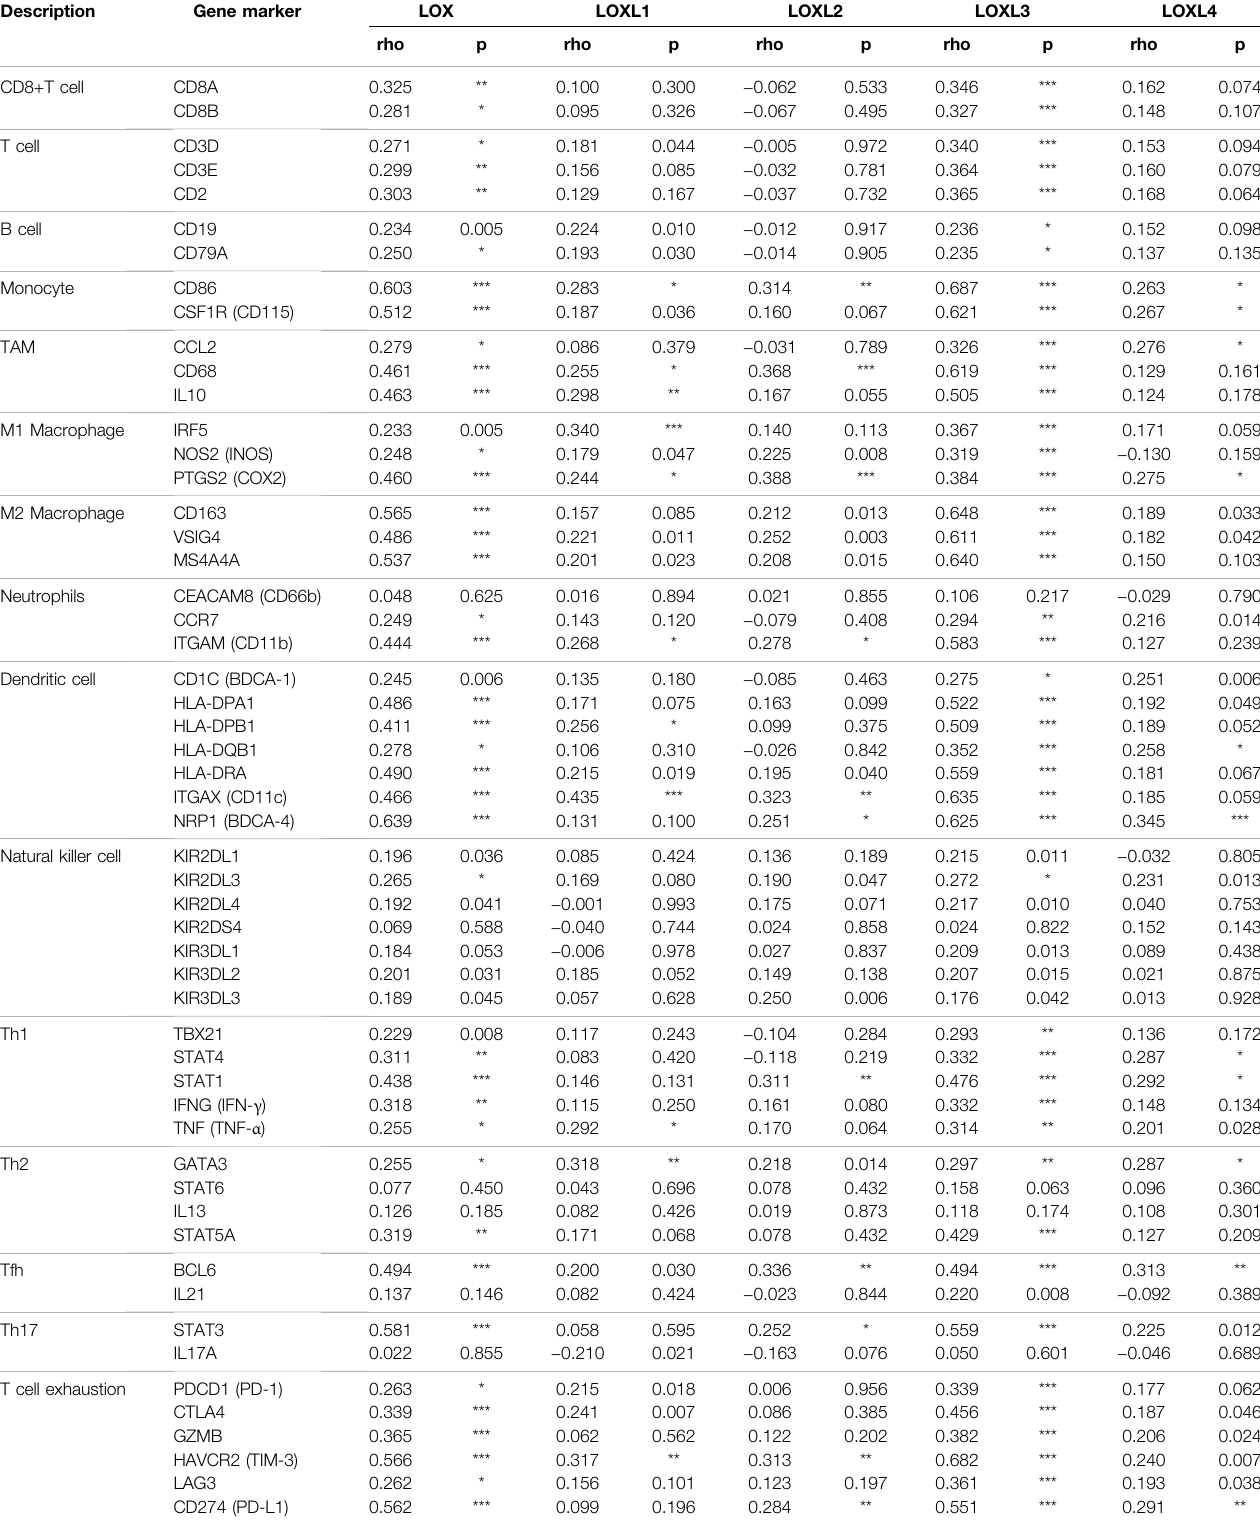
TABLE 2 | Correlation analysis of LOXs and immune biomarkers in PAAD (TIMER).